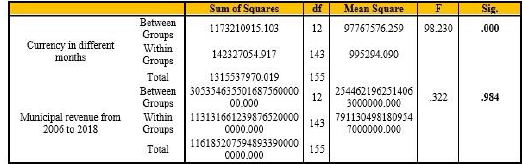
Table 3: ANOVA Testing for Municipality Income and U.S. Dollars